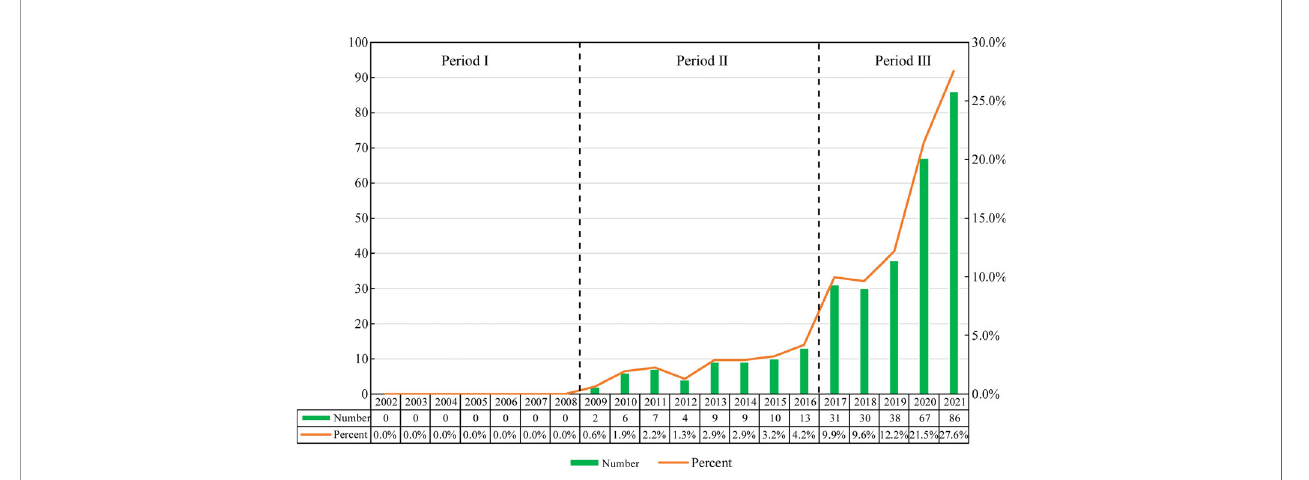
FIGURE 2 | Annual output of research of exosomes in